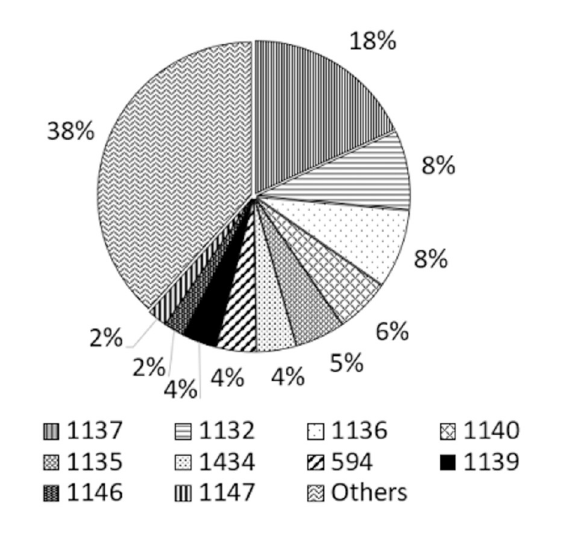
Fig 1. Percentage distribution of commonest STs.